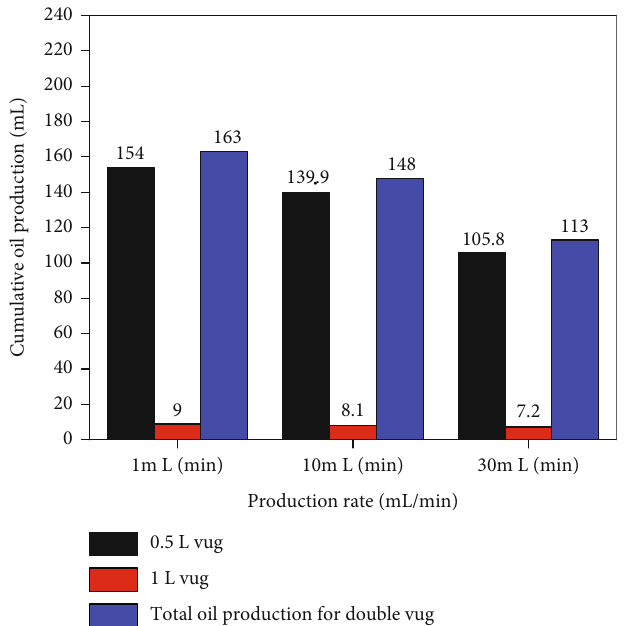
Figure 9: Column chart of cumulative oil production in high-pressure physical property experiments under connection type II (di ff erent production